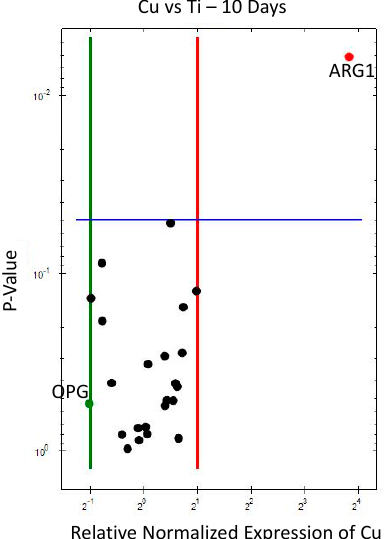
Figure 2. Volcano plot for gene expression of Cu compared to Ti (10 days). Downregulation (vertical green line) and upregulation (vertical red line) set at ×2 regulation. Statistical significance (set at p < 0.05) when marker above horizontal blue line.